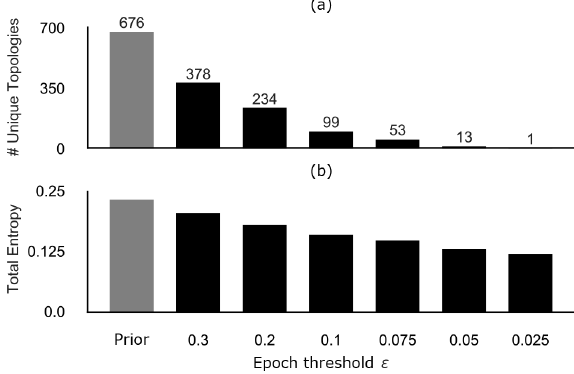
Figure 12. (a) Number of unique topologies within the geomodel ensembles of each SMC epoch, showing the iterative reduction in topological uncertainty throughout the SMC simulation. (b) Aver- age geomodel entropy of the ensembles for each epoch, showing how the reduction of topological uncertainty shown in (a) affects the total geomodel